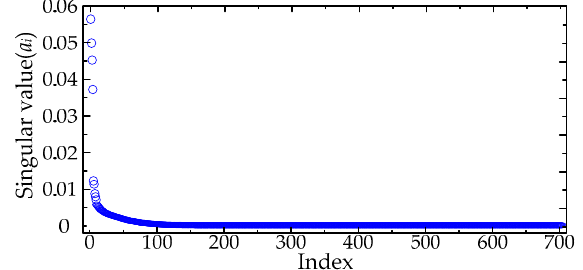
Figure 6. Calculated singular values by decomposing the MTFM.